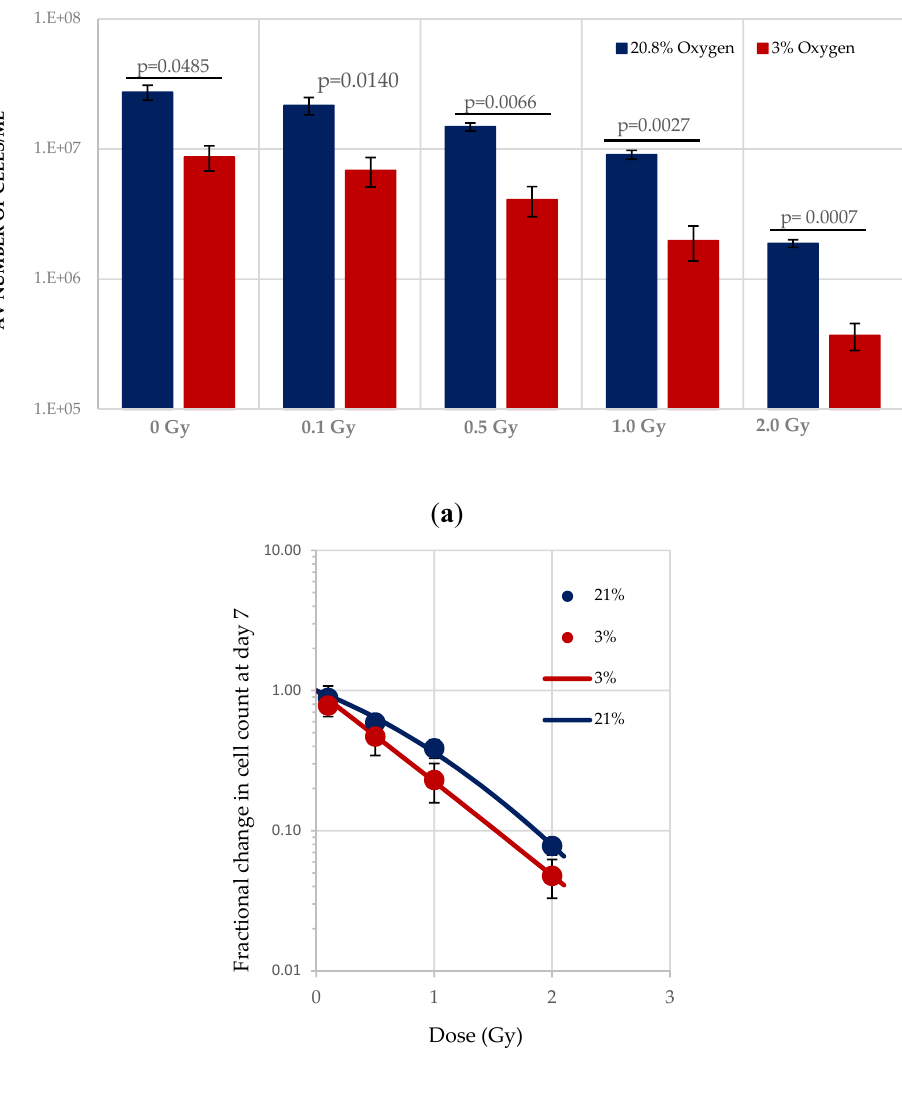
Figure 2. ( a,b ). Effect of oxygen stress and IR exposure on the proliferative capability of HSPCs at day 7. HSPCs (2 × 10 5 cells/well, x-irradiated (0–2 Gy) were irradiated under normoxia and subsequently incubated under low O 2 or normoxia and regular cell counts were carried out to day 14 ( N = 3; 3 wells/dose/experiment; error bars represent ±SEM). ANOVA and multiple comparison tests were applied. Time and O 2 level showed statistical significance in each dose with p = 0.0001 or p < 0.0001. Subject was not significant. The plating efficiency for both normoxic and low O 2 cultures was ~75–80%.